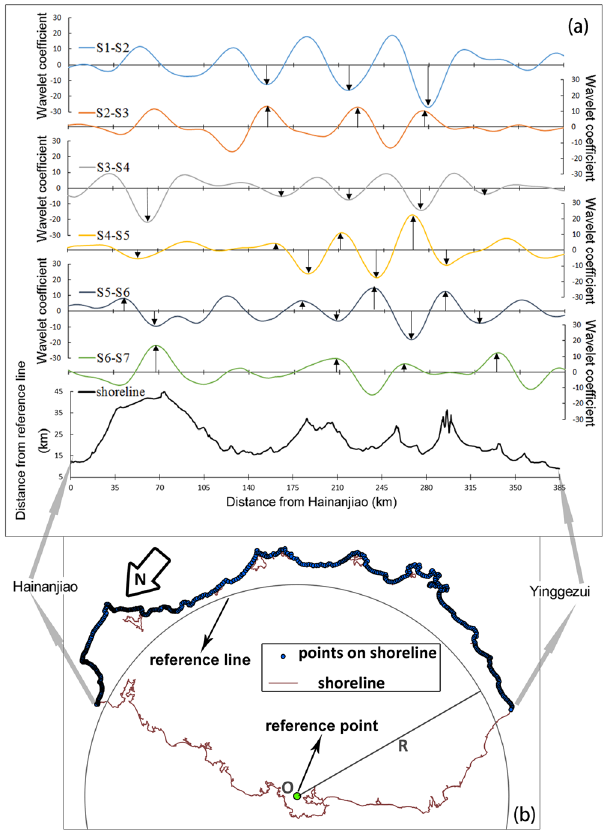
Figure 4. Wavelet coefficients of shoreline change series for the scale parameter a = 3 and a sketch of the coast. The bottom curve in ( a ) is based on ( b ), where the distance from the reference line equals the distance between O and points on the coast line minus the radius of the reference line, R. The position of the reference point, O, is 109.6964°E, 19.3257°N. The adjacent wavelet coefficient series usually present as mirror image of each other, and large amplitudes of these coefficients appear in relatively fixed areas. Arrows within the coefficient curves show the seriously eroded coastal areas after strong storms, which are efficiently recovered afterwards. The map in ( b ) is generated using ArcMap [10.1] (http://www.esri.com/) and the shoreline is based on the topographic and bathymetric data from GEBCO